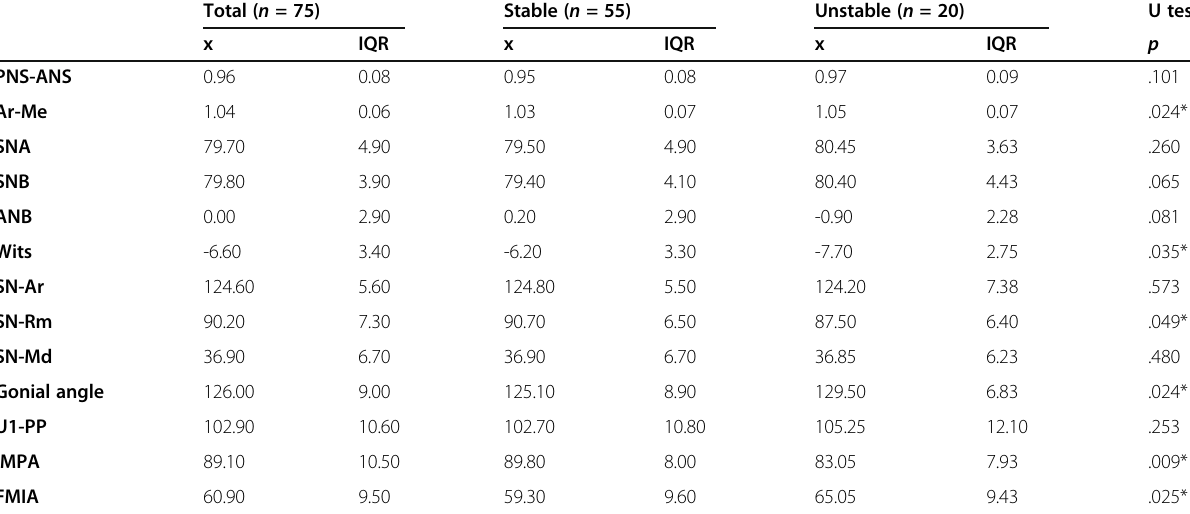
Table 5 Destrictive statistics and significance probabilities of cephalometric variables Total ( n = 75) Stable ( n = 55) Unstable ( n = 20)